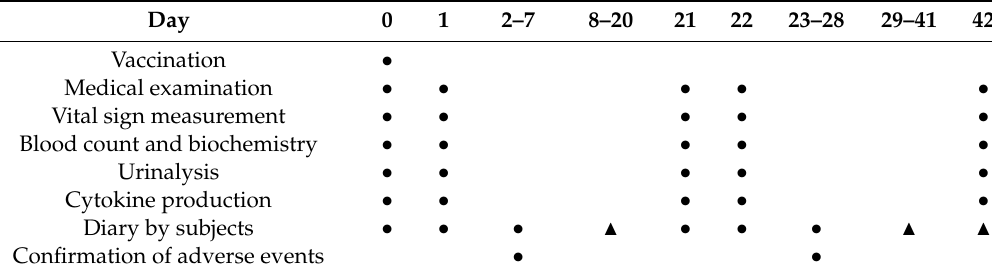
Table 2. The clinical protocol for assessing the safety of the K3-loaded